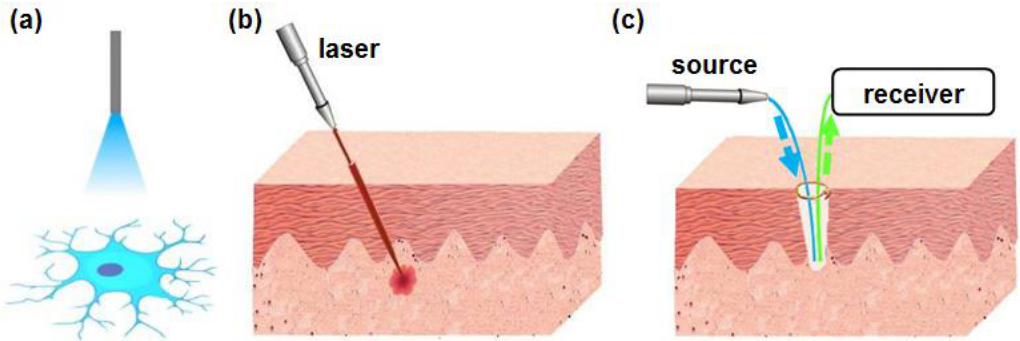
Figure 7. Schematically illustrated examples of applications for implantable fiber/waveguides. ( a ) Optogenetics. ( b ) Laser surgery. ( c ) Fluorescence sensing.